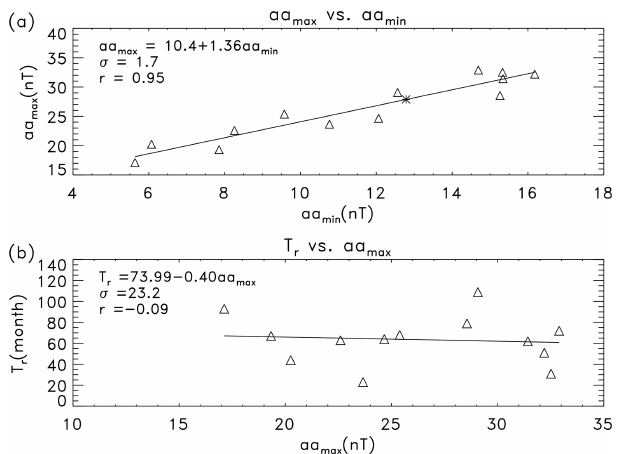
Figure 7. The time difference between aa max and R m (a) and that between aa min and R min (b)